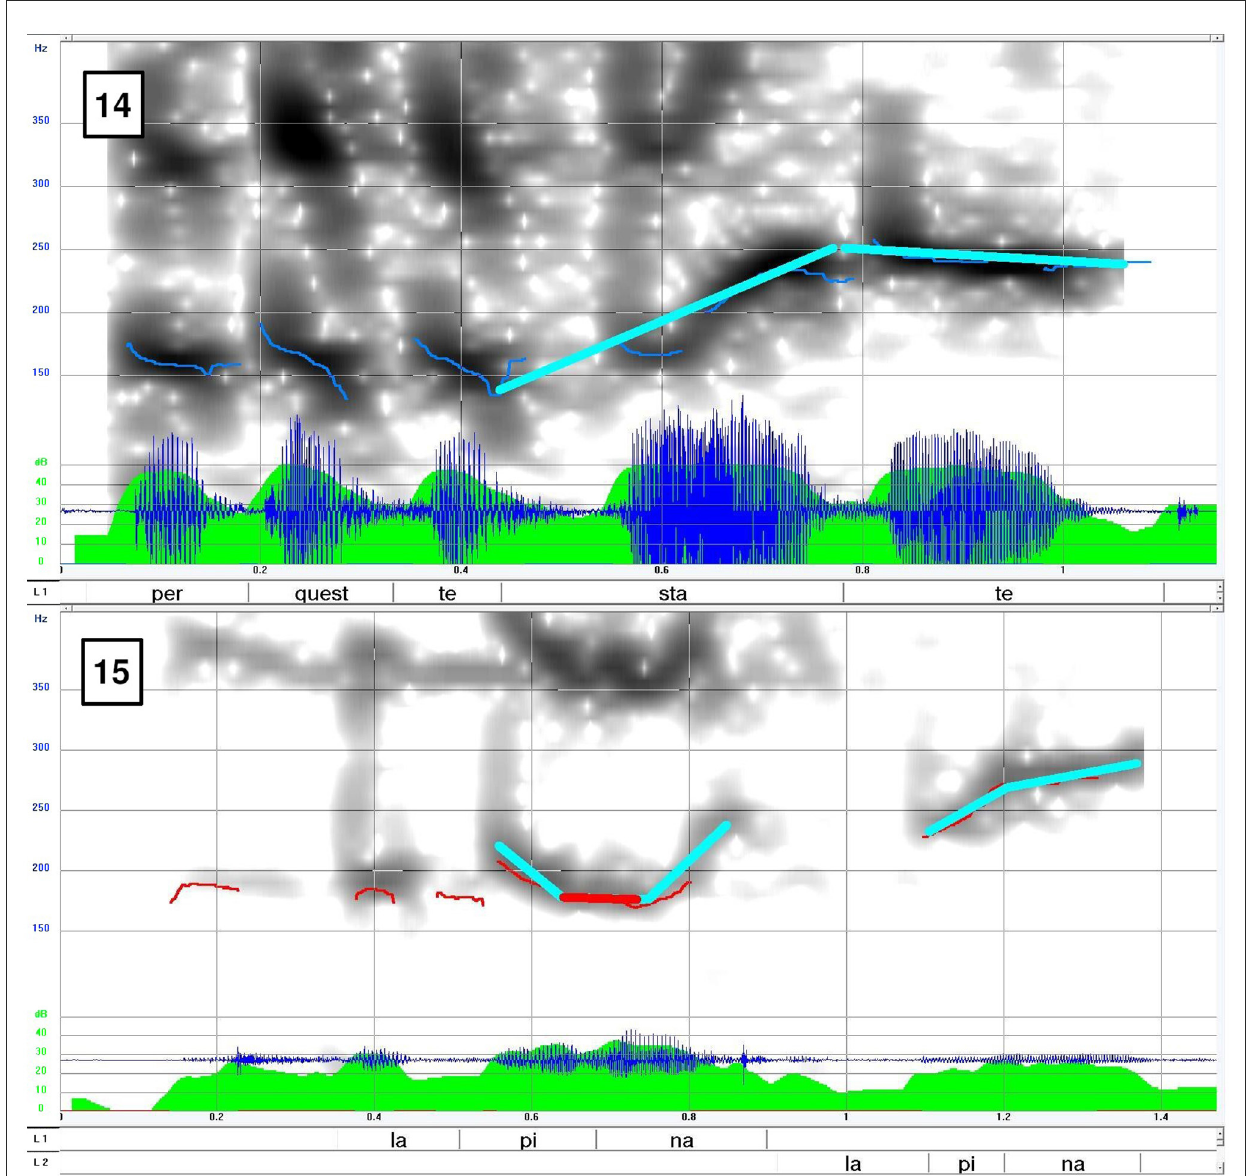
FIGURE9 Prototypic contours of Open questions in Italian (14; 15) (Supplementary Audio